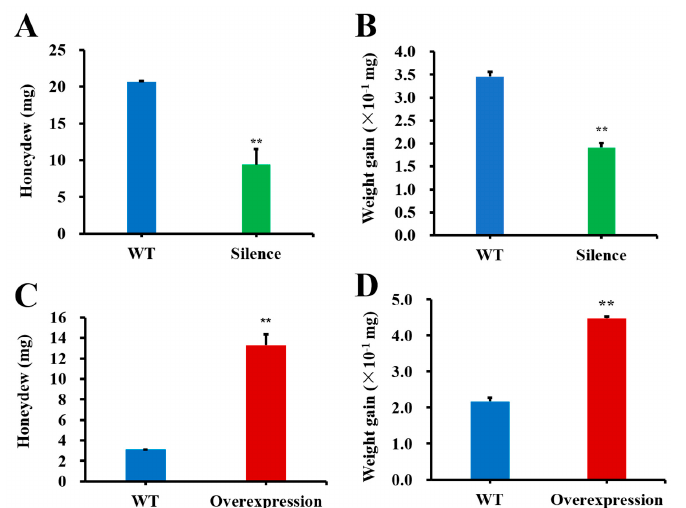
Figure 9. Effects on performance for WBPH feeding on transgenic plants. ( A ) Honeydew and ( B ) weight gains of WBPH feeding on SFMLP - dsRNA -transgenic plants (silence). ( C ) Honeydew and ( D ) weight gain of WBPH feeding on SFMLP -overexpressing transgenic plants (overexpression). ** indicates statistically significant differences ( t- test: p < 0.01). Bars, ±SEM.